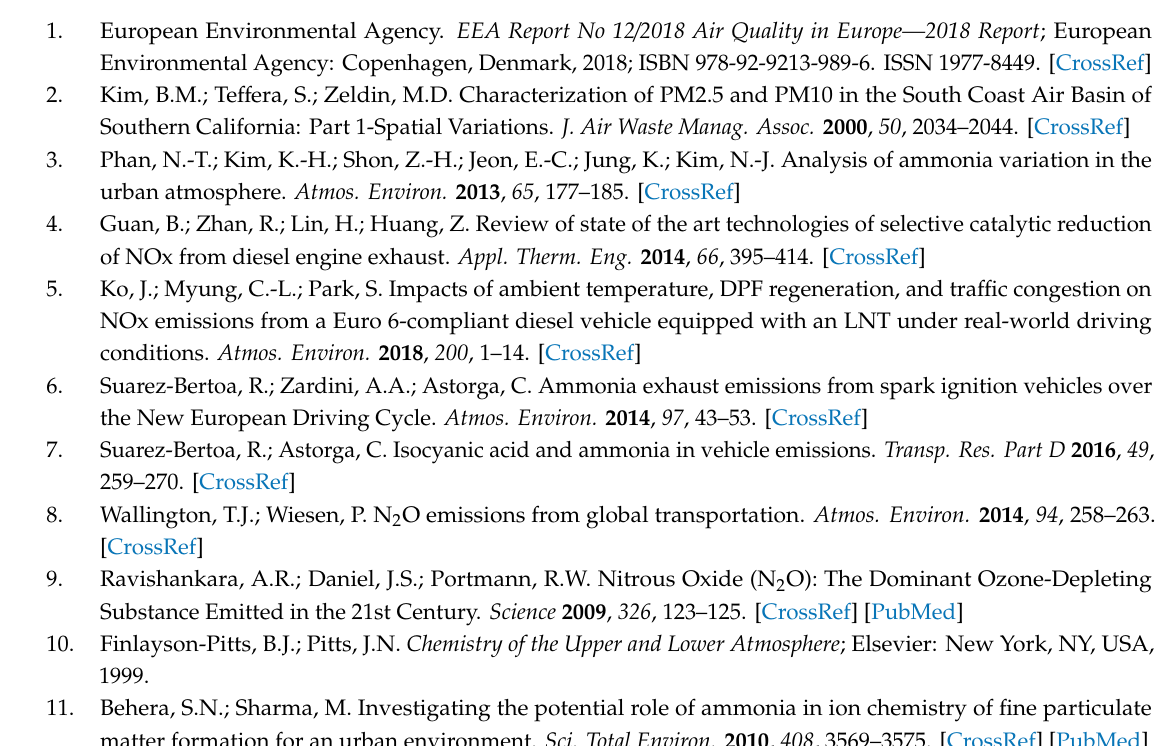
Figure S1. Altitude profile (brown line) and speed profile (blue line) of (a) Route-1, (b) Route-2 and (c) Route-3; Figure S2. (a) NH 3 , (b) CH 4 and (c) N 2 O emission profiles registered with the portable FTIR (orange line) and lab-grade FTIR (black line) during a WLTP test performed with DV1; Figure S3. NH 3 , N 2 O, NO, NO 2 , CO, CH 4 , and HCHO on-road emissions profiles registered during a DPF regeneration event of the DV1; Figure S4. (a) CO emission profile from the CNG-LCV measured using NDIR present in the PEMS (black line) and the portable FTIR (red line). (b) CO emission profile (red line) and N 2 O emission profile (blue line) measured using the portable